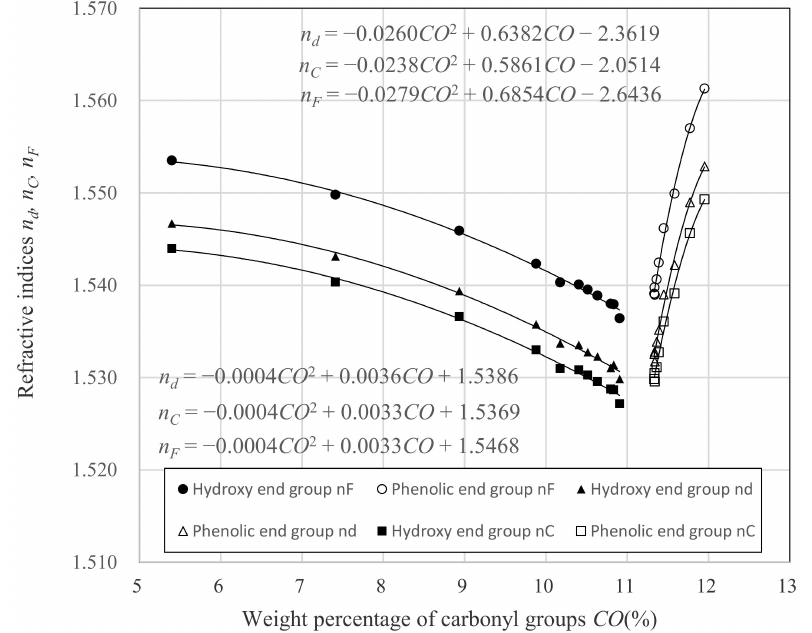
Figure 8. Relation between weight percentage of the carbonyl groups CO and n d , n C , and n